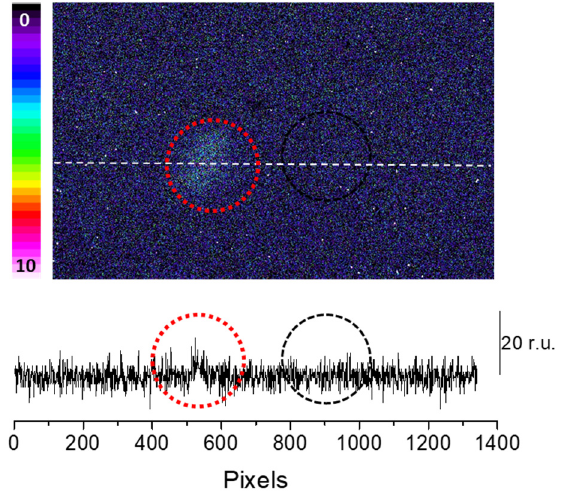
Figure 4. Fenton reagent-induced two-dimensional ultra-weak photon emission imaging from porcine ear measured after the topical application of Fenton reagent (10 mM H 2 O 2 /250 µ M FeSO 4 ) in the presence of interference filter type 644 (340–540 nm). The circle indicates the untreated (red) and treated (black) areas of the porcine skin with sodium ascorbate. Other experimental conditions as described in Figure 3. The Y-axis in the lower panel reflects the number of photon counts accumulated after 30 min, whereas the X-axis denotes the pixel of the image.